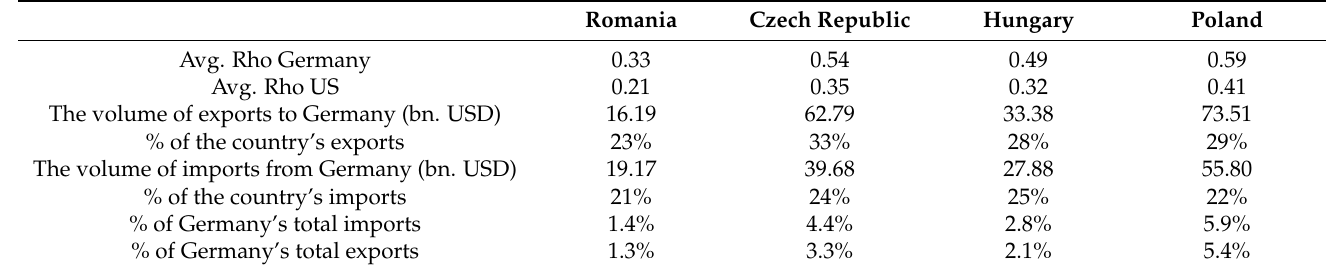
Table 4. The average conditional correlation coefficient and the volume of trade (exports and imports) between CEEC countries and Germany and the US